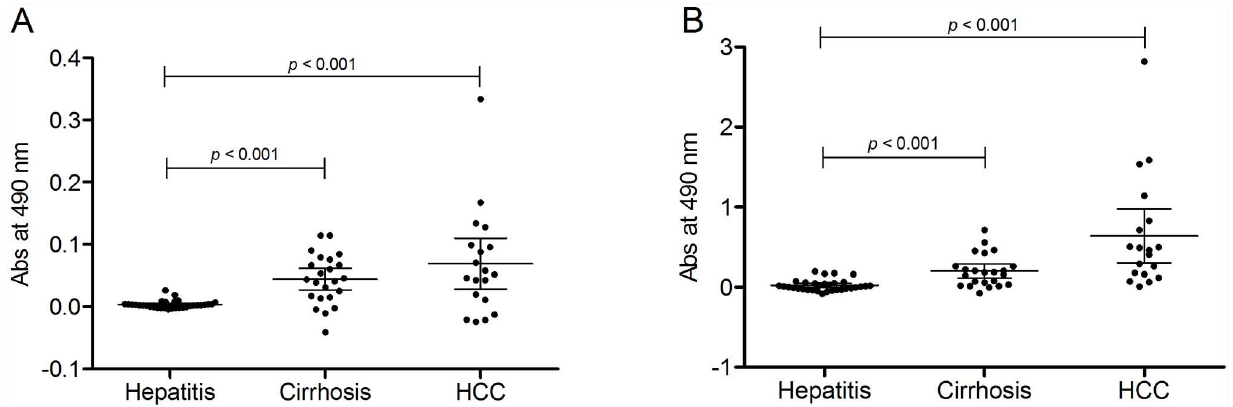
Fig 6. Scatter plots of bound fucosylated AGP in a traditional lectin ELISA (A) and in a reversedS2 lectin ELISA (B).